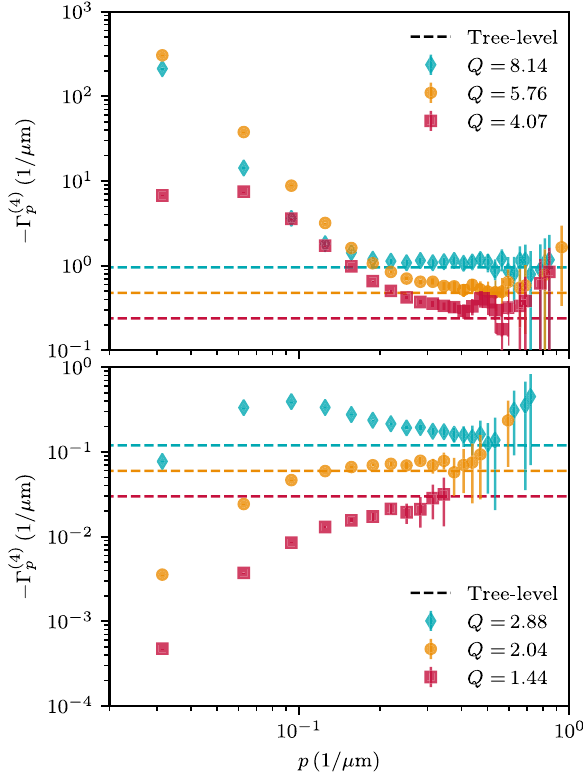
FIG. 5. Loop corrections to the 1PI four-vertex for different values of Q . The (negative) four-vertex (blue diamonds, orange circles, and red squares), shown for larger values of Q (upper, corresponding to Fig. 4), clearly approaches the corresponding tree-level predictions (colored dashed lines) at high momenta. In the infrared, we observe a strong momentum dependence, increasing the effective coupling. For decreasing values of Q (lower), the (negative) four-vertex is increasingly suppressed in the infrared. The results are consistent with the approach of the tree-level prediction (colored dashed lines) for high momenta. Numerical results are calculated for L ¼ 100 μ m and a sample size of 10 8 . The error bars indicate the standard error of the mean. Note that we exclude data points at high momenta with errors larger than the mean from this